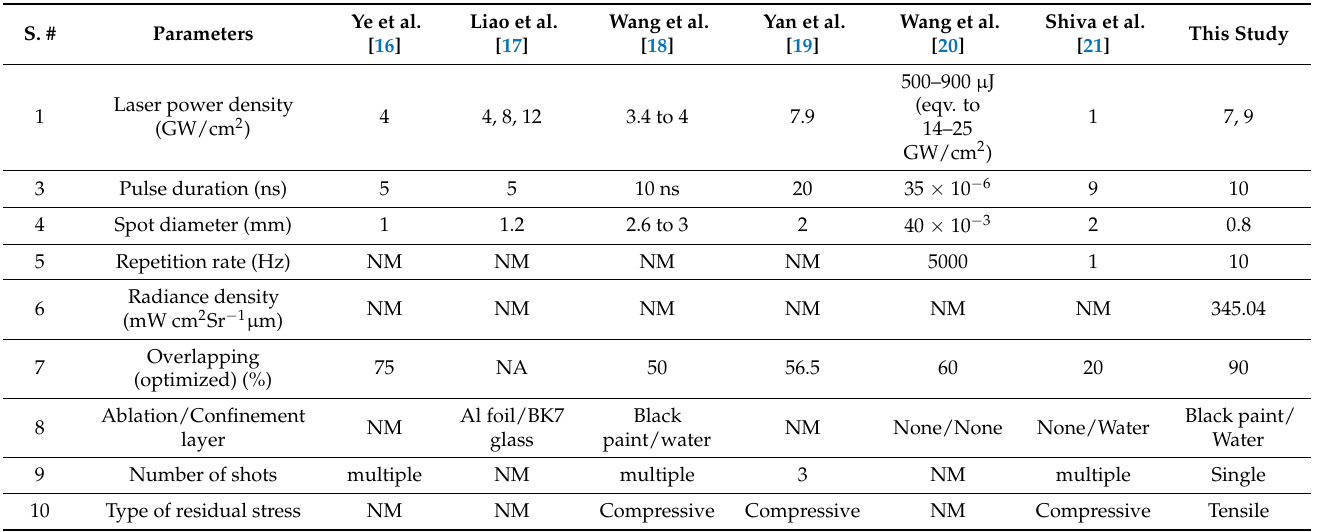
Table 1. Summary of the laser peening parameters adopted for studying Nitinol. NM in the table stands for “not